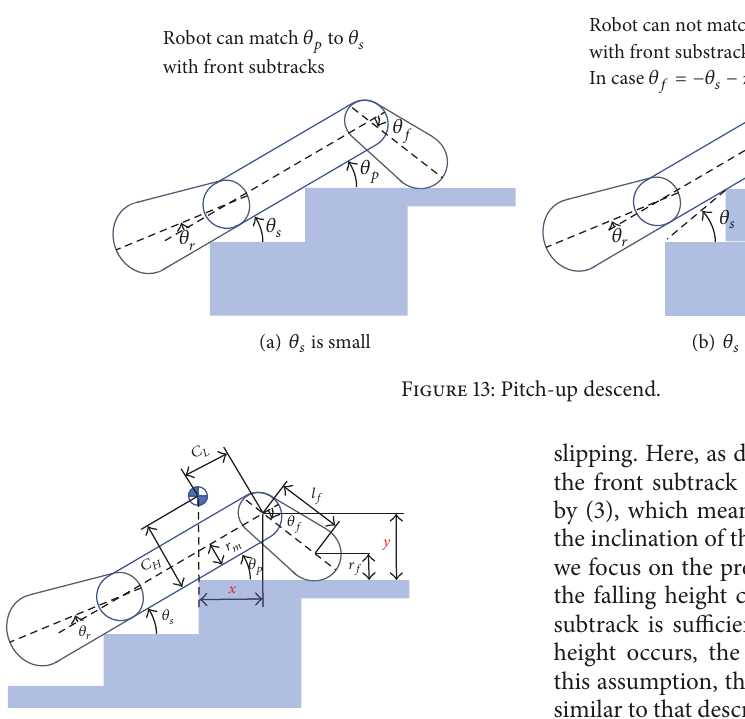
Figure 14: State to switch to normal climbing-down